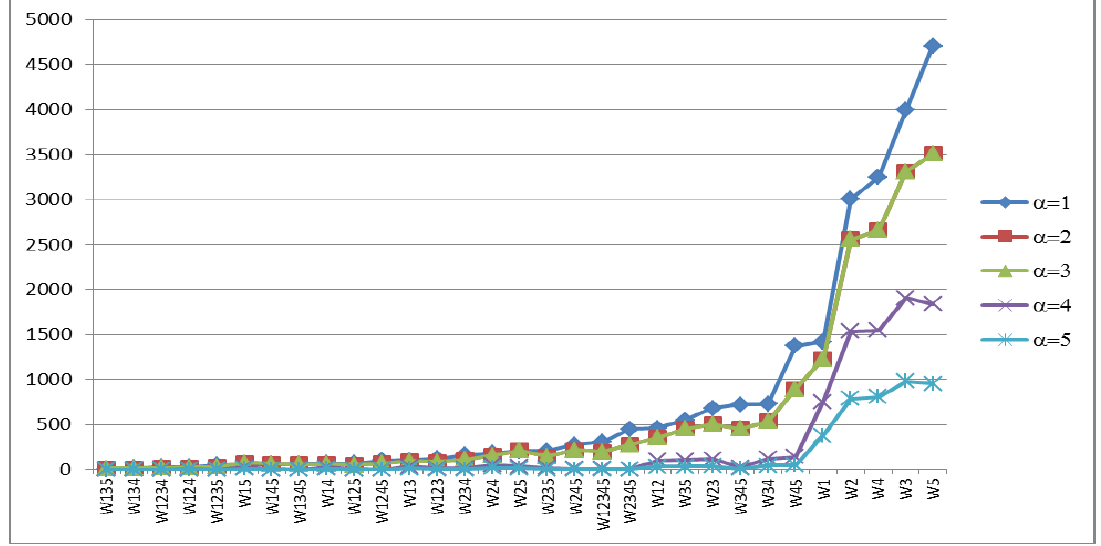
Figure 5 Number of users active in different windows depending on α